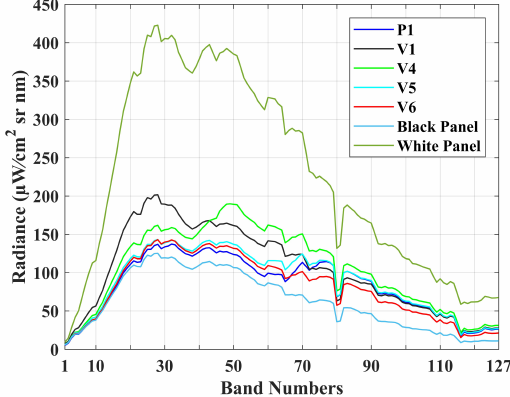
Figure 5. The radiance spectra of targets in the SIM.GA dataset.